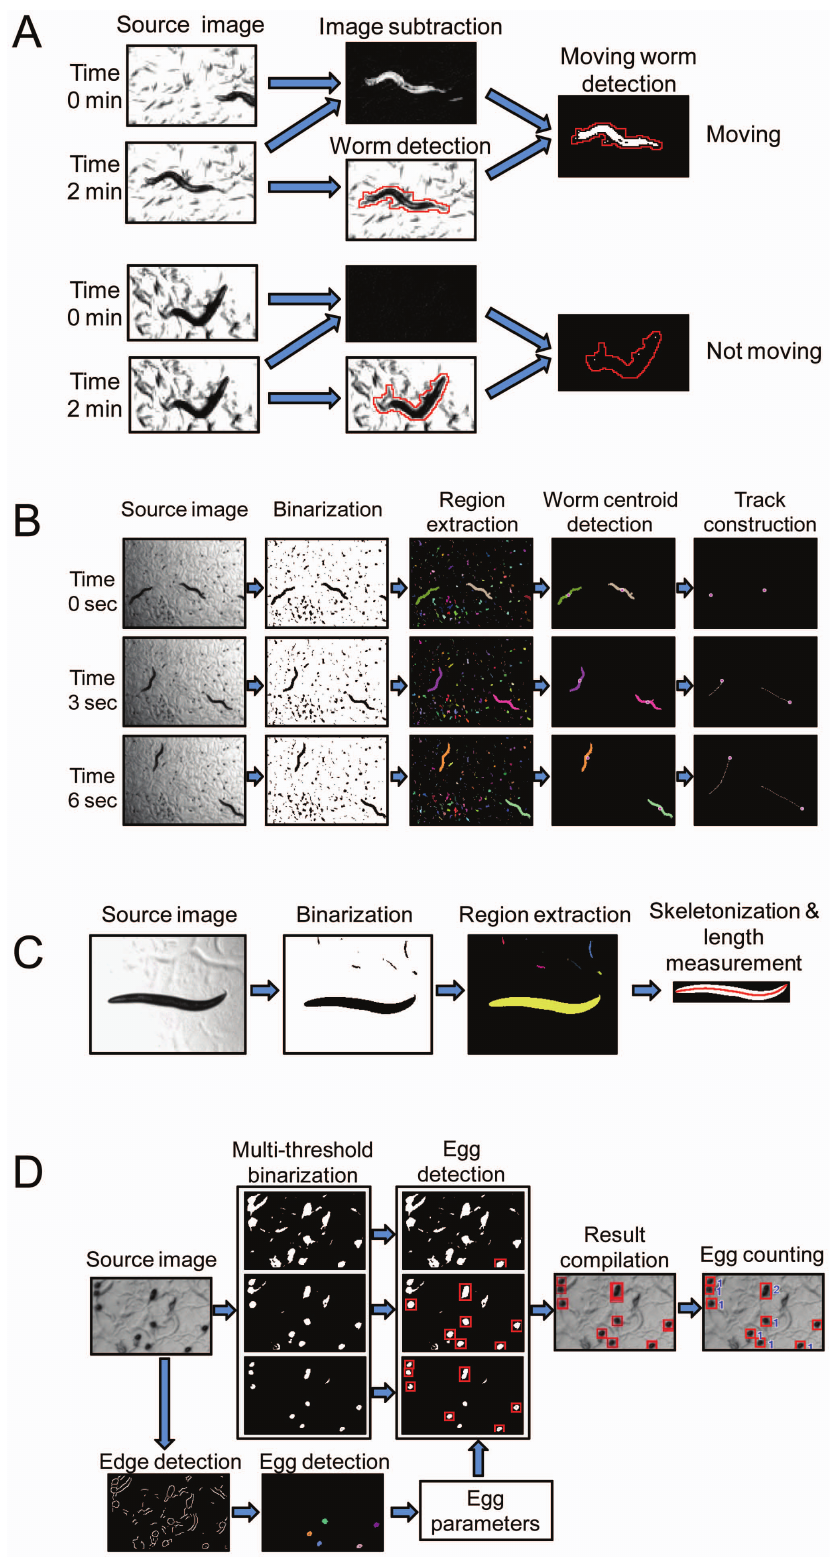
Figure 2. QuantWorm image processing algorithms. (A) WormLifespan. Two time-lapse images are obtained, and a differential image is created by subtracting the second time-lapse image from the first time-lapse image. Independently, individual worms are detected in the second image and are defined as region of interest (ROI). Worm movement is determined by counting the number of white pixels. (B) WormLocomotion. Image frames from videos are binarized and region-extracted to detect objects. Worms are indentified by analyzing the morphology of detected